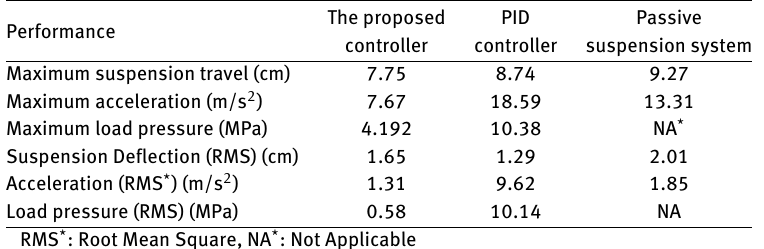
Table 6. Performance comparison while the system with nominal parameters is imposed by bump road profile depicted in Figure 3.